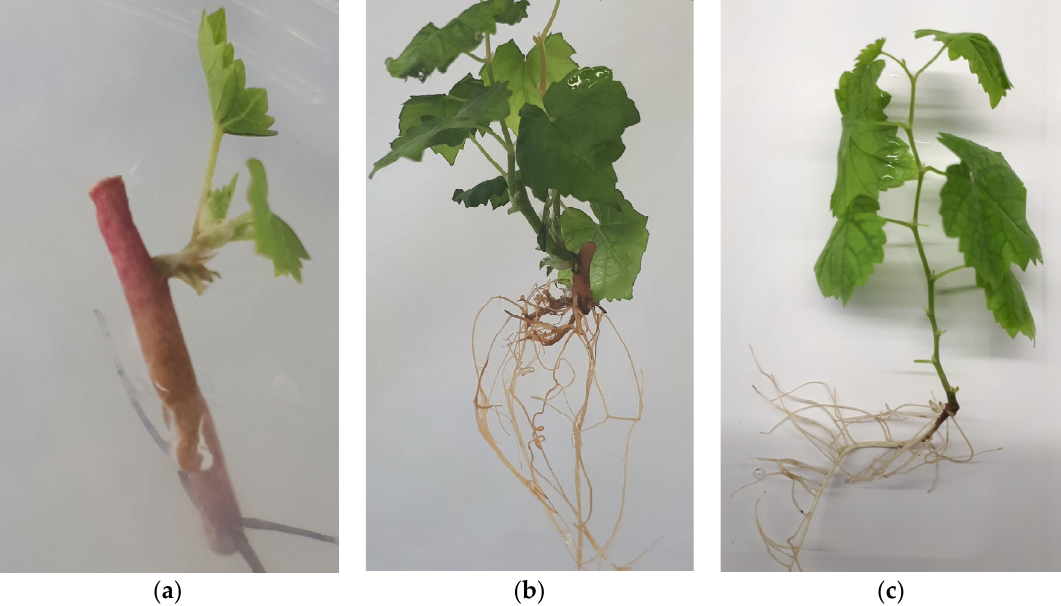
Figure 1. ( a ) Micrograft at the beginning of shoot and root development; ( b ) well-developed micro- graft; ( c ) micropropagated grapevine separated from rootstock.